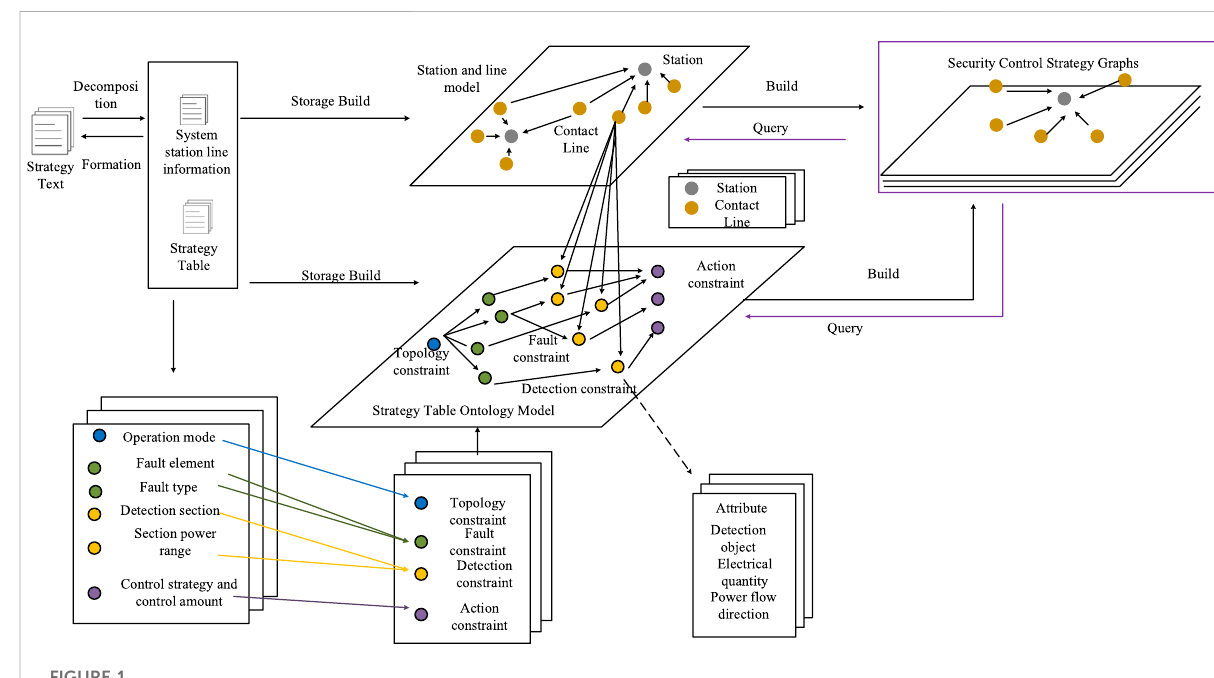
FIGURE 1 Modeling framework of security and stability control strategy based on the knowledge